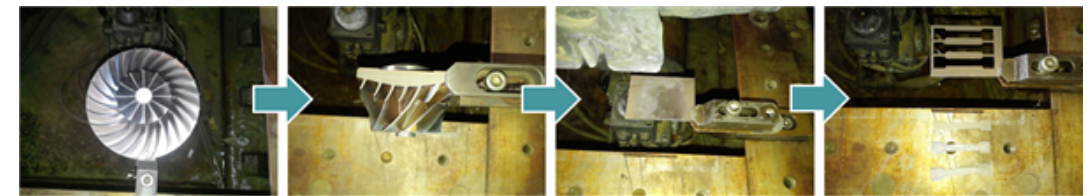
Figure 1. Wire-cutting process for test samples from the impeller